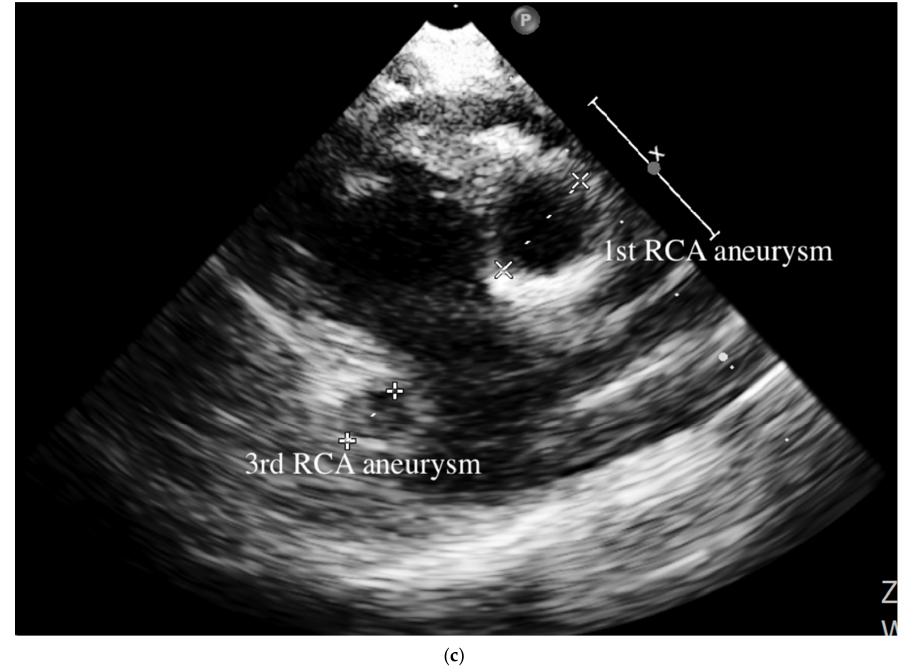
Figure 1. Transthoracic echocardiology on the 16th months after illness of aneurysm. Three RCA aneurysms in a beaded arrangement from the subcostal view of echocardiography ( a ) and trans- thoracic echocardiogram imaging showed first with second RCA aneurysm ( b ) as well as first with third RCA aneurysm ( c ).